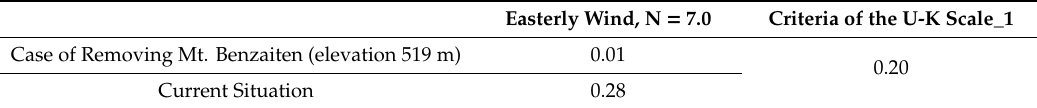
Table 7. Values of the U-K Scale_1 with horizontal grid resolution set to 5 m.